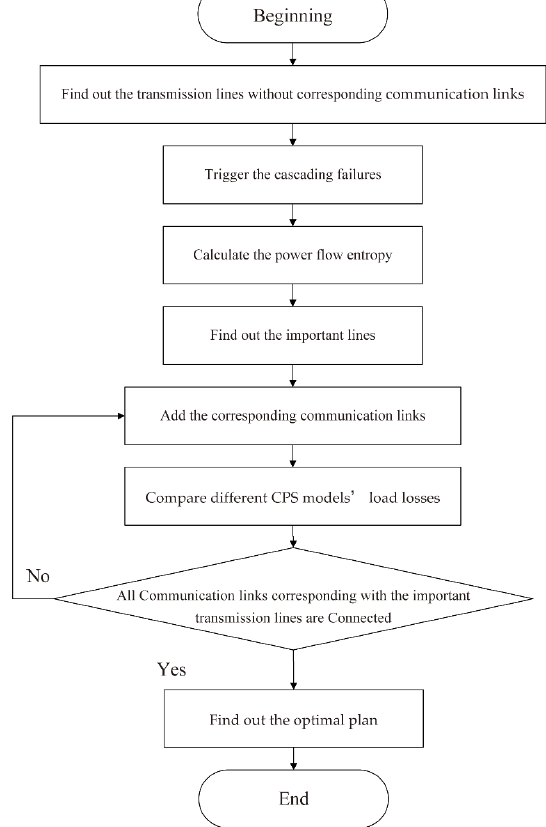
Figure 4. The simulation flow chart of cascading failure.